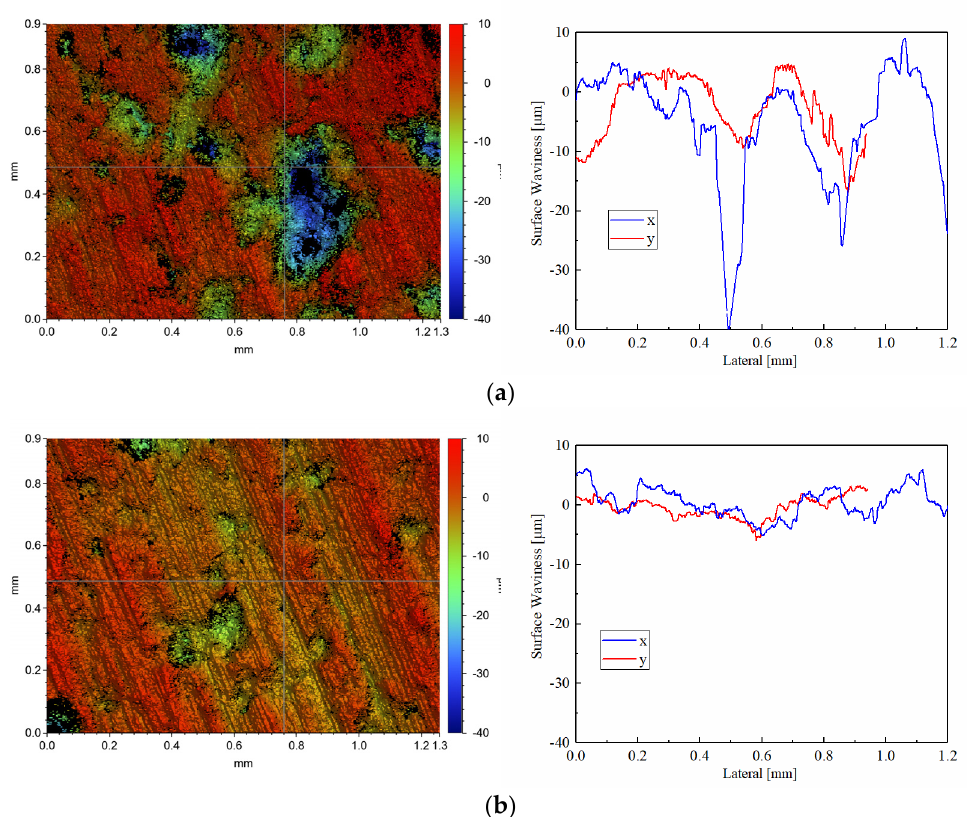
Figure 11. The white light interferometric profilometry (×50) and surface waviness of pre-test in CBFM-A ( a ) and CBFM-B ( b ).